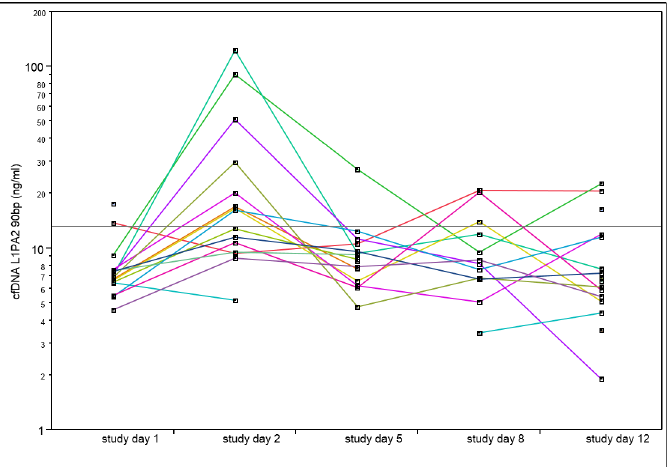
Missing values lead to interruptedlines (see methods).